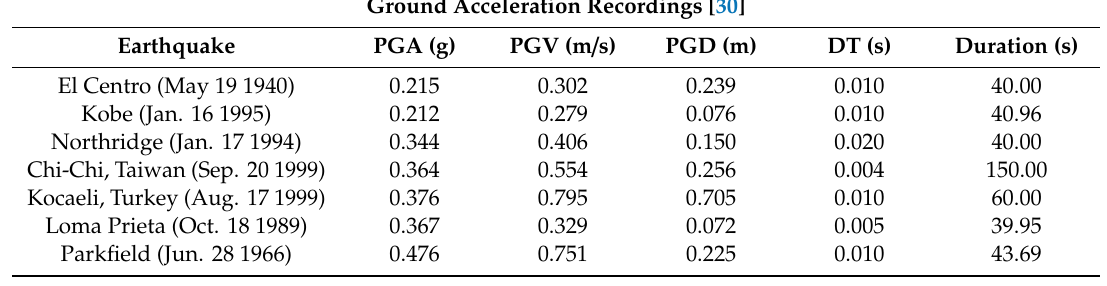
Table 2. Parameters considered in the time history analysis.